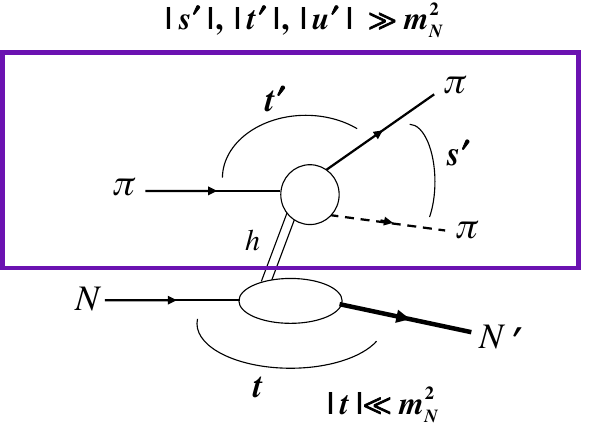
Figure 6. π − N → π − π + p process. Here, s (cid:48) , t , t (cid:48) , u , are the Mandelstam variables, m N denotes the mass of the nucleon, and h indicates the intermediate hadronic state.